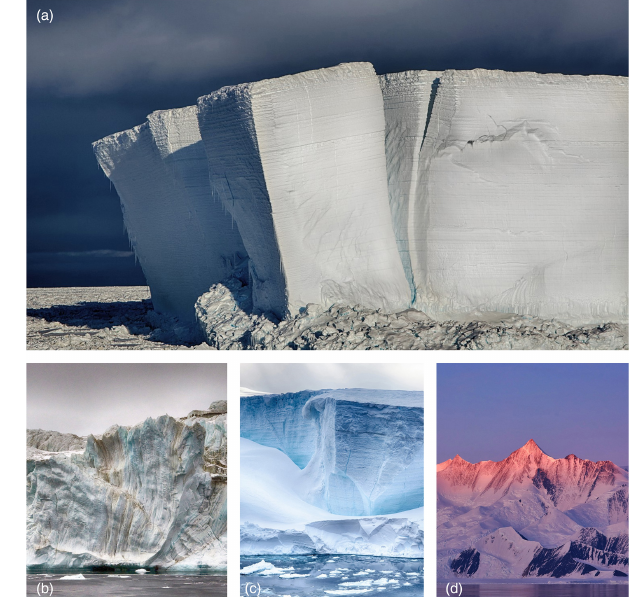
Figure 6. Antarctic landscapes. (a–c) XXVIII PNRA expedition under the ROSSLOPE II project. (a) Iceberg stacked in Cape Hallett in the Ross Sea. (b) Campbell glacier detail in the southwestern Ross Sea. (c) Floating blue iceberg in the Ross Sea. (d) Drygalski glacier tongue in the Ross Sea during the XXXI PNRA expedition under the HOLOFERNE project.